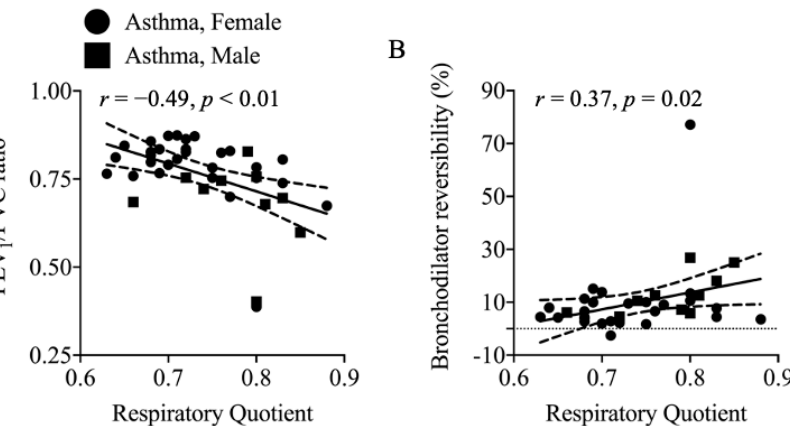
Figure 3. Correlations between Fasting Substrate Oxidation and Respiratory Function in